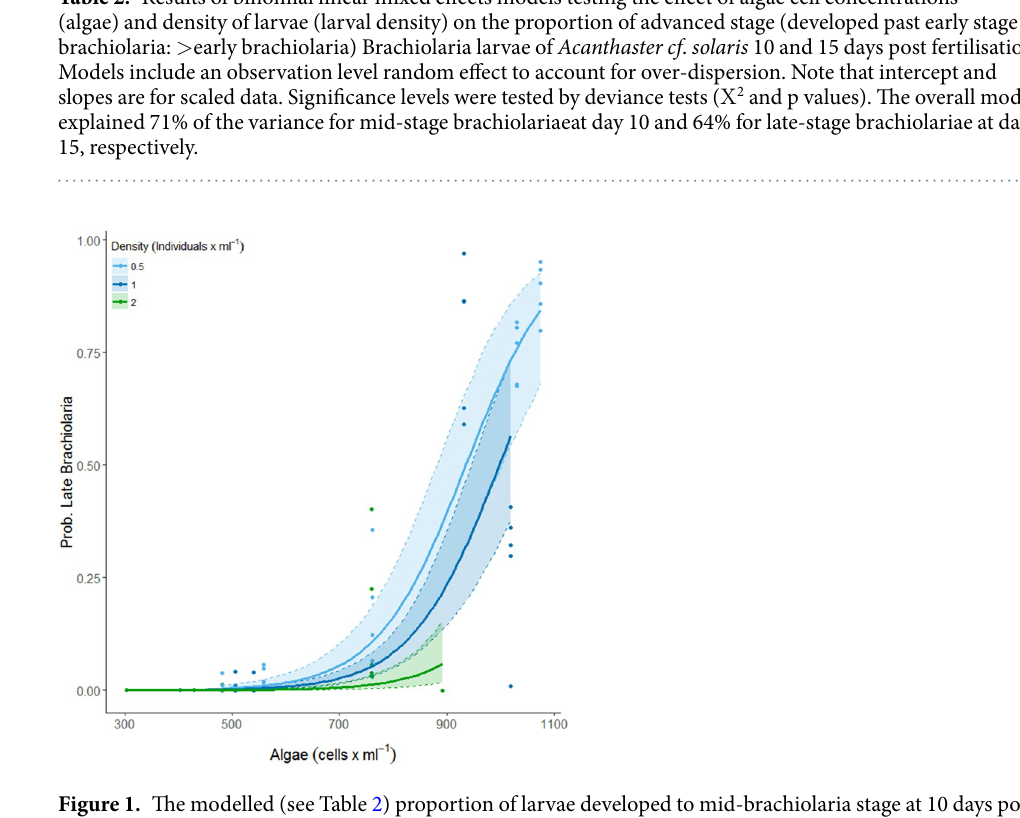
Figure 1. The modelled (see Table 2) proportion of larvae developed to mid-brachiolaria stage at 10 days post fertilisation. Confidence intervals derived from bootstrap (N = 1000) analysis, dots represent partial residuals at the tank level derived from the